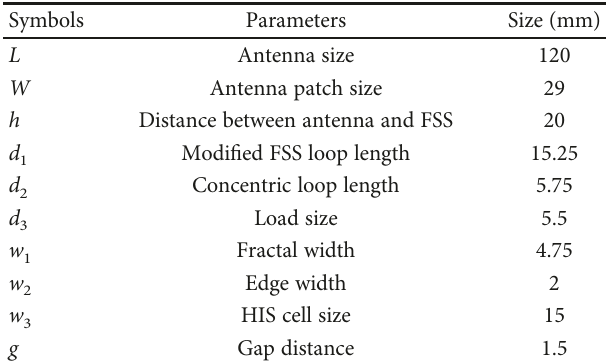
Figure 12: Simulated electric fi eld distribution (a) conventional microstrip antenna and (b) proposed microstrip antenna with HIS elements and modi fi ed FSS superstrate. Table 1: The optimal dimensions of the microstrip antenna with the HIS elements and FSS